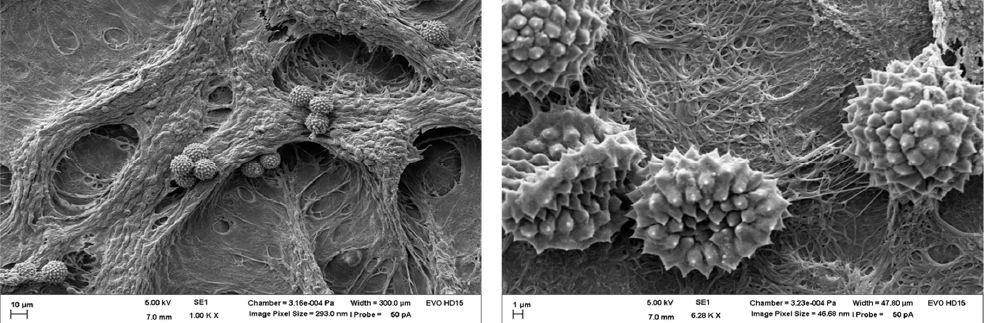
Figure 6. Scanning electron microscopy (SEM) images after deposition with VPC of pollen from Iva xanthiifolia on MucilAir™. Left: SEM picture of Iva xanthiifoli a on MucilAir™ with an image pixel size Iva xanthiifolia on MucilAir™. Left: SEM picture of Iva xanthiifolia on MucilAir™ with an image pixel of 293.0 nm and a magnification of 1.000×; right: SEM picture Iva xanthiifoli a on MucilAir™ with an size of 293.0 nm and a magnification of 1.000 × ; right: SEM picture Iva xanthiifolia on MucilAir™ with image pixel size of 46.68 nm and a higher magnification of 6.280×. an image pixel size of 46.68 nm and a higher magnification of 6.280 ×